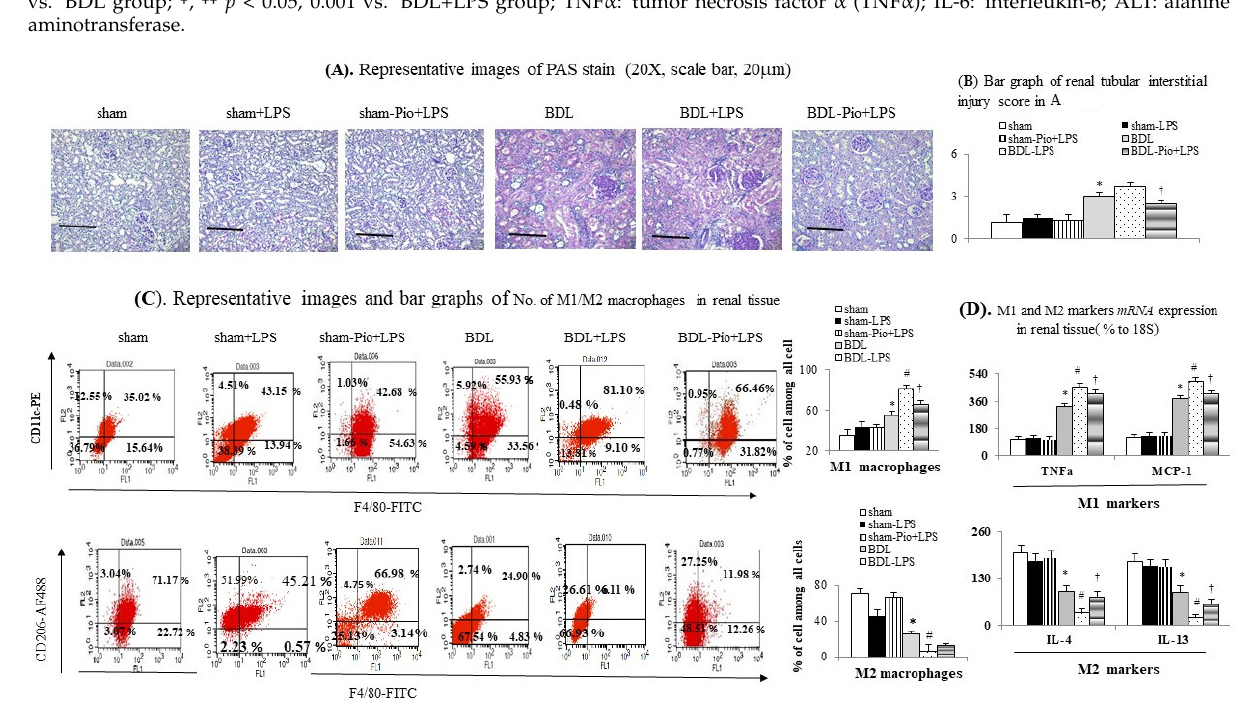
Figure 3. Chronic pioglitazone treatment suppressed the lipopolysaccharide (LPS)-induced acute on chronic renal injury by the prevention of increased renal M1 macrophages. ( A , B ) Renal PAS stain; ( C ) frequency of M1/M2 macrophages in renal tissue; ( D ). mRNA of M1/M2 markers in homogenates of renal tissue. * p < 0.05 vs. sham group; # p < 0.05 vs. BDL group; † p < 0.05 vs. BDL ‐ LPS.